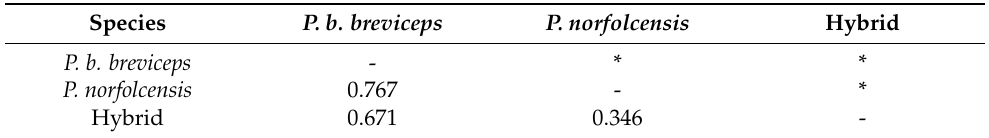
NS = not significant ( p >